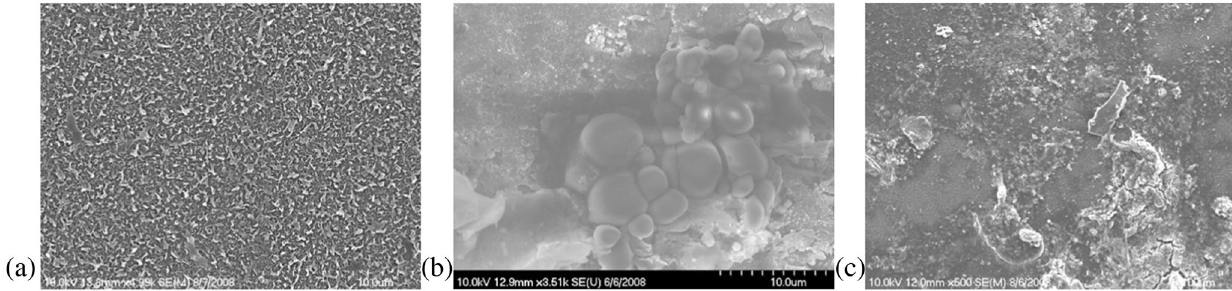
Fig. 1 Scanning electron microscope images of NF membranes at a seawater desalination plant. Virgin ( a ), fouled ( b ) and cleaned ( c ) NF membranes from the Long Beach Water Departments ’ s (Long Beach, California, USA) seawater desalination plant 13 . Copyright Desline.